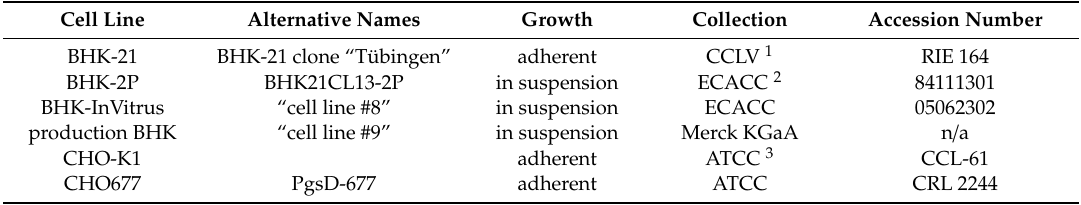
Table 1. Cell lines used in the